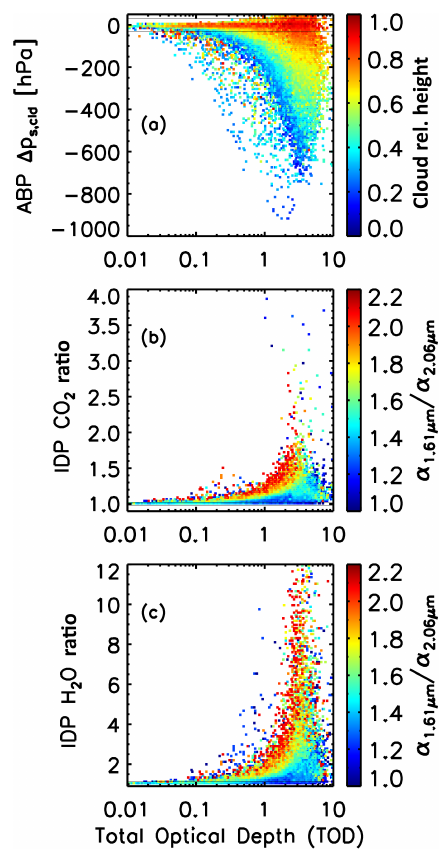
Figure 1. Scatter plots of (a) (cid:49)p s , cld , (b) CO 2 ratio ( R CO ) and 2 (c) H 2 O ratio ( R H ) versus the total optical depth for OCO-2 sim- 2 O ulations over land for the month of June. In panel (a) , each sounding is colored according to the cloud relative height (see text), while in panels (b) and (c) , each sounding is colored according to the ratio of the 1.6 to the 2.0µm retrieved effective albedo. The horizontal black lines show the selected threshold values presented in Table 1. hPa/hPa. Values near 0 (blue colors) represent high cloud or aerosol layers, while values near unity (red colors) represent low cloud or aerosol layers. The horizontal black lines in the figure show thresholds used to separate cloudy scenes from clear sky. The (cid:49)p s , cld test is two sided; deviations from the ECMWF a priori, either high or low, will cause the scenes to be flagged as cloudy. For the OCO-2 instrument model, the value of (cid:49)p s , cld di- verges from 0 at a lower TOD for the high clouds (blue col- ors) than it does for low clouds (red colors). This is an indi- cator of the ABP’s ability to detect high, optically thin clouds due to strong PPL modification. However, the ABP has more difficulty identifying low clouds, even some that are optically thick, as seen by the large number of bright red data points with small (cid:49)p s , cld at high TOD. This is due to their relatively small effect on